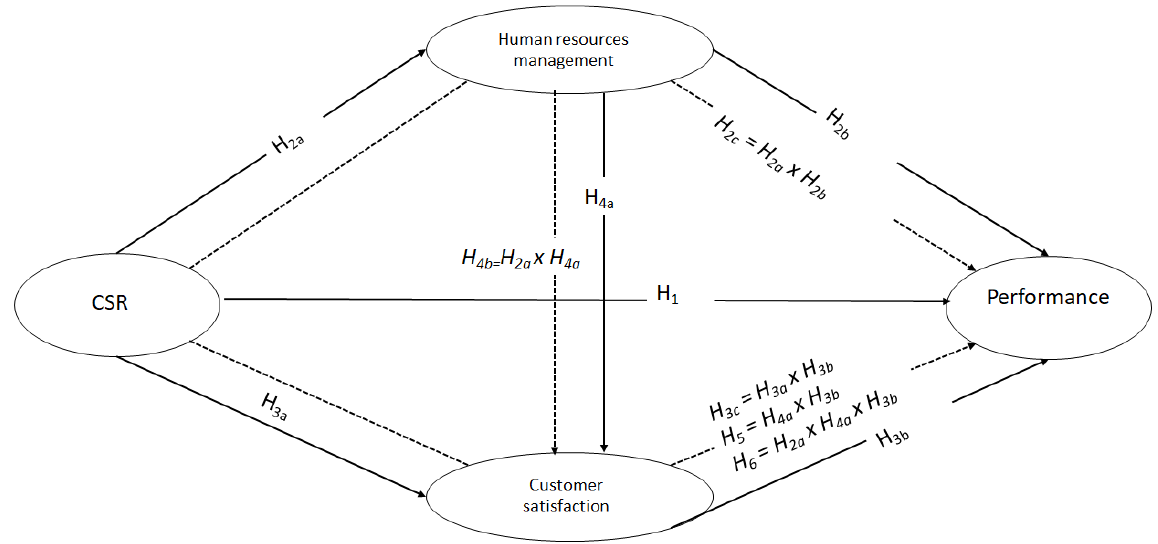
Figure 1. Research model. Note: The path lines in H2 c , H3 c , H4 b , H5 and H6 represent mediation relationships. Source: Authors.